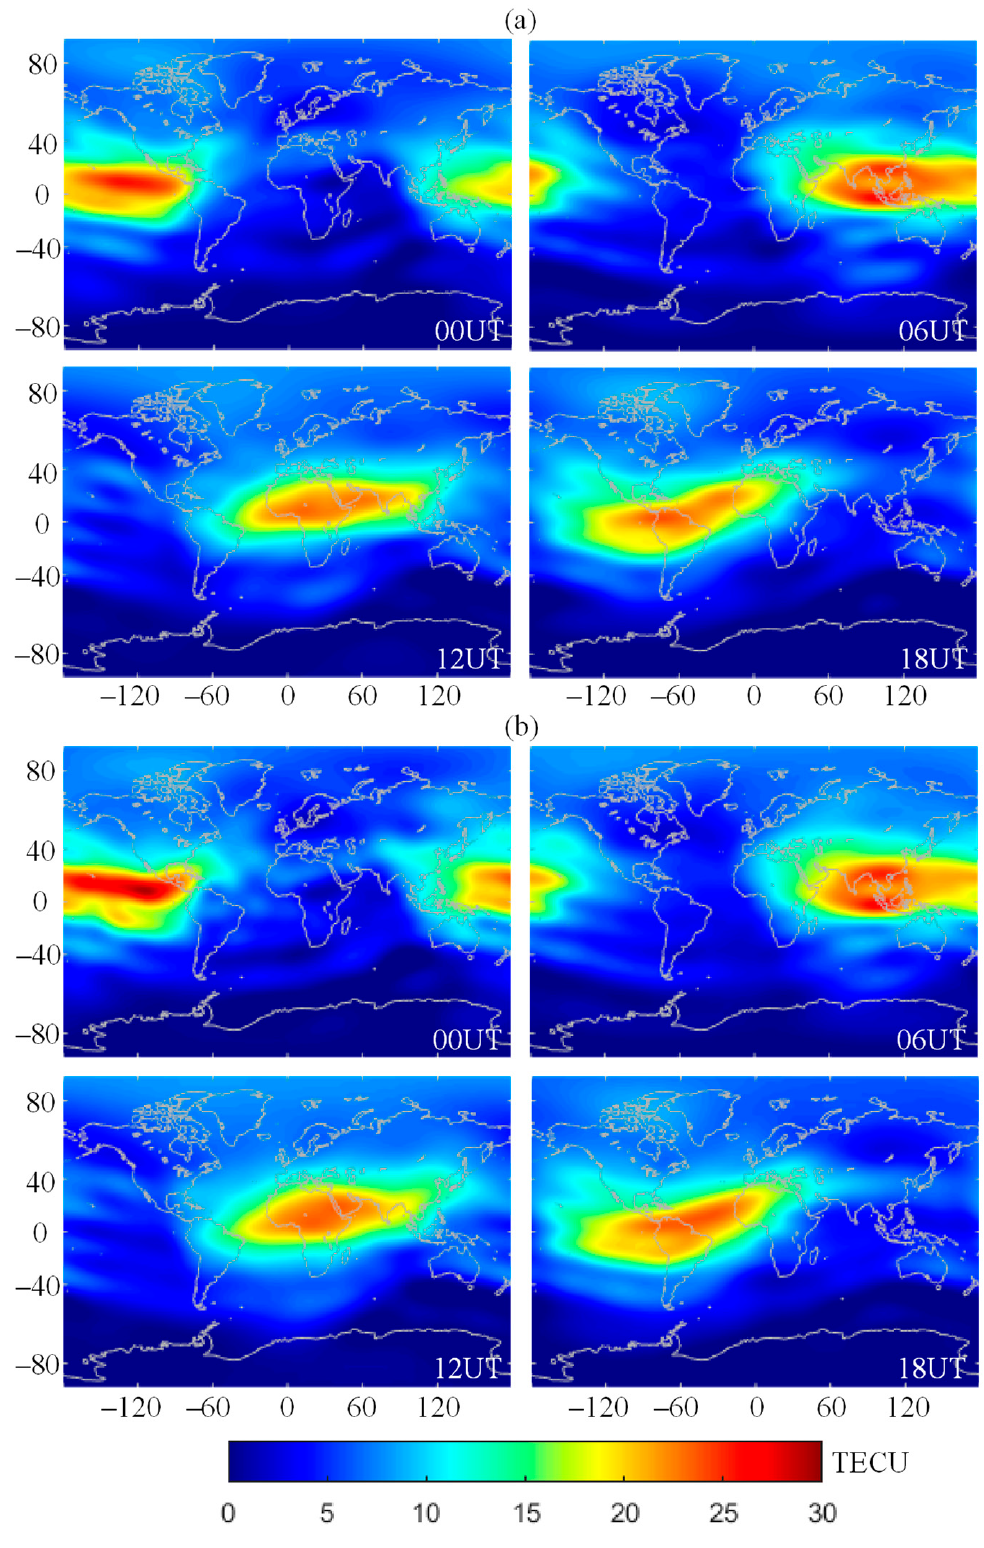
Figure 1. The forecasted global ionospheric TEC maps on 1 June 2019, as obtained ( a ) using the Prophet model and ( b ) from the COPG values, with a time interval of 6 h, longitude on the horizontal axis, and latitude on the vertical axis.